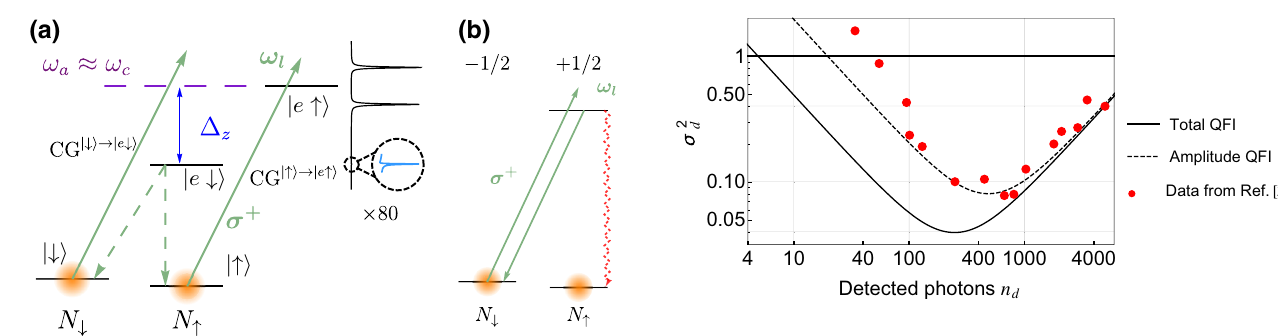
FIG. 8. Measurement quality of the system σ 2 measurement spin noise normalized to SQL ) for the chirped two- color measurement, with total atom number N = 1000, single atom cooperativity η = 1.8, and a total quantum efficiency for detecting photons of q = 0.15. The solid black curve corresponds to the theoretical model including both the total QFI and Raman scattering noise, and the dashed black curve only includes the QFI contained in the transmission amplitude. The red points are experimental data from Ref. [27]. The detection limit σ 2 improves with photon number n d as the fractional photon shot noise is reduced, and then increases with n d due to spontaneous Raman